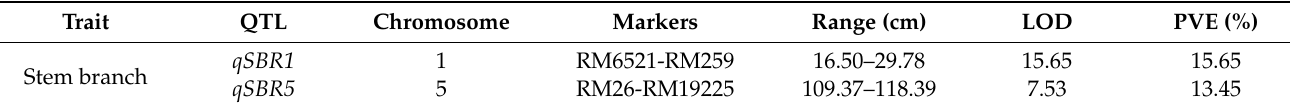
Table 5. QTLs controlling stem branch in